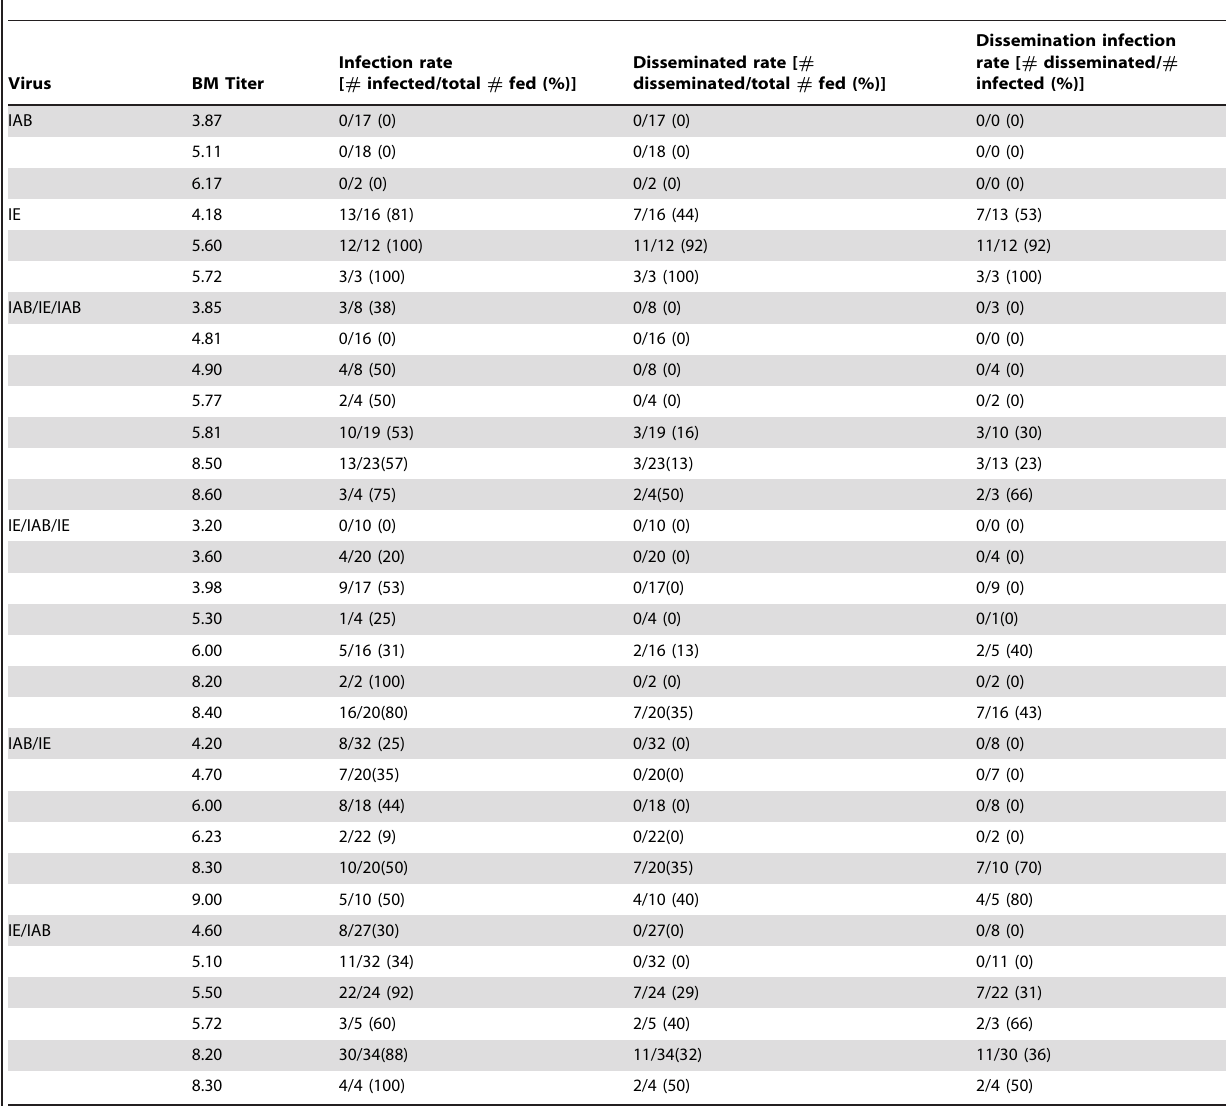
Table 2. Virus infection and dissemination rates in C. taeniopus .